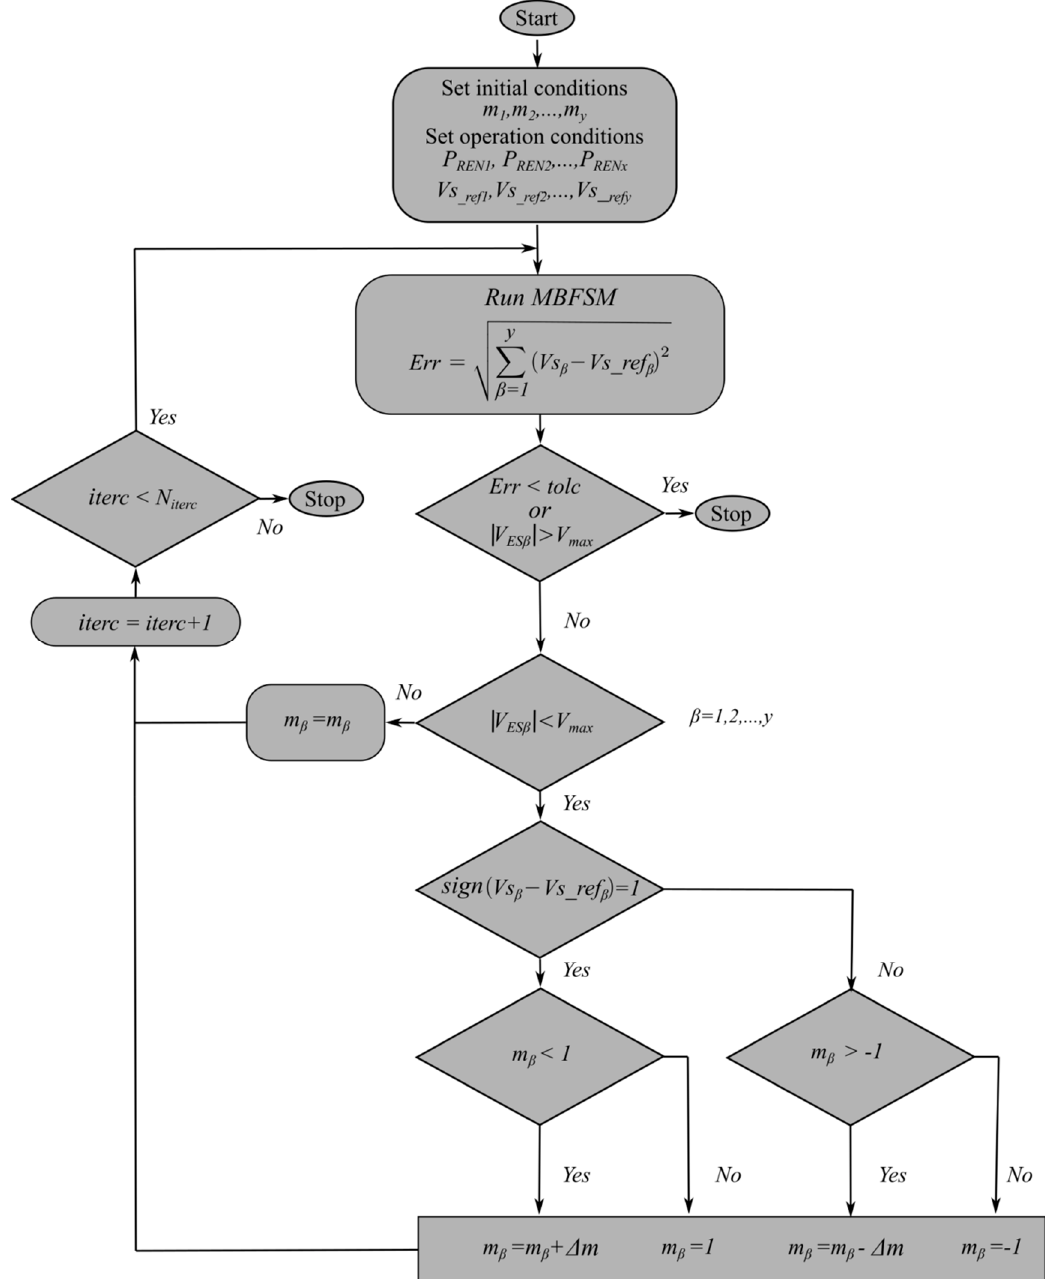
Figure 7. Voltage control flow chart.